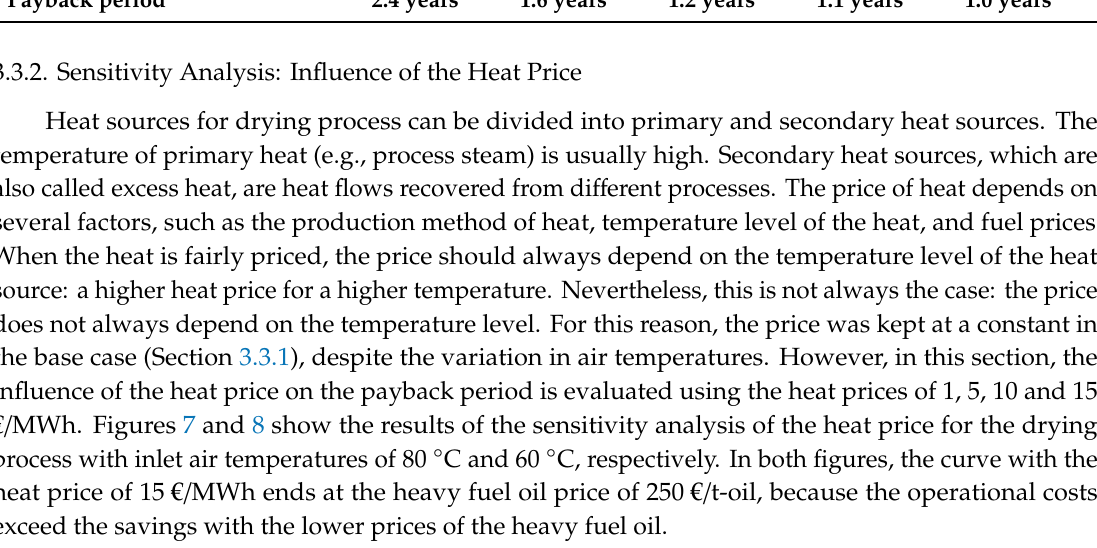
Figure 8. The payback periods when the heat prices of 1, 5, 10, and 15 €/MWh are used. The inlet air temperature of the drying air is 60 °C. All other initial values are shown in Table 5. Figure 7 shows that the soot sludge and sawdust mixture drying is profitable (maximum payback period 3 years) with all heat prices when the heavy fuel oil price is at least 330 €/t-oil. Furthermore, Figure 8 shows that the drying is profitable (payback period max 3 years) with all heat prices when the heavy fuel oil price is at least 360 €/t-oil. These results indicate that it is economical to dry the soot sludge with the current oil price (410 €/t-oil) despite the relatively high heat price. The heat price of 15 €/MWh is a rather typical price level for process steam in the industry. Waste heat is usually much cheaper. Results with varying heat prices also show that there is no reason to use higher drying air temperatures than 60–80 °C because drying is always economic with current oil price even if the heat price was 15 €/MWh. If there are several heat sources with varying heat prices available, cases should be analysed in more detailed to find the optimal drying temperature. Low drying temperatures with low heat prices result in high investment costs (dryer size + heat exchanger areas) but low operational costs and vice versa when drying temperatures are high. This is a classic optimization problem that has been studied for example by Holmberg et al. [32]. 3.3.3. Sensitivity Analysis: Influence of the CO 2 Emission Price This section evaluates the influence of the CO 2 emission price on the payback period when emission prices are 3, 7, 11, and 15 €/t-CO 2 . Between the years of 2013 and 2018, the price of the CO 2 emission has varied from 3 to 14 €/t-CO 2 within the European Union [29]. Figure 9 shows the results of the sensitivity analysis of emission price for the drying process with an inlet air temperature of 80